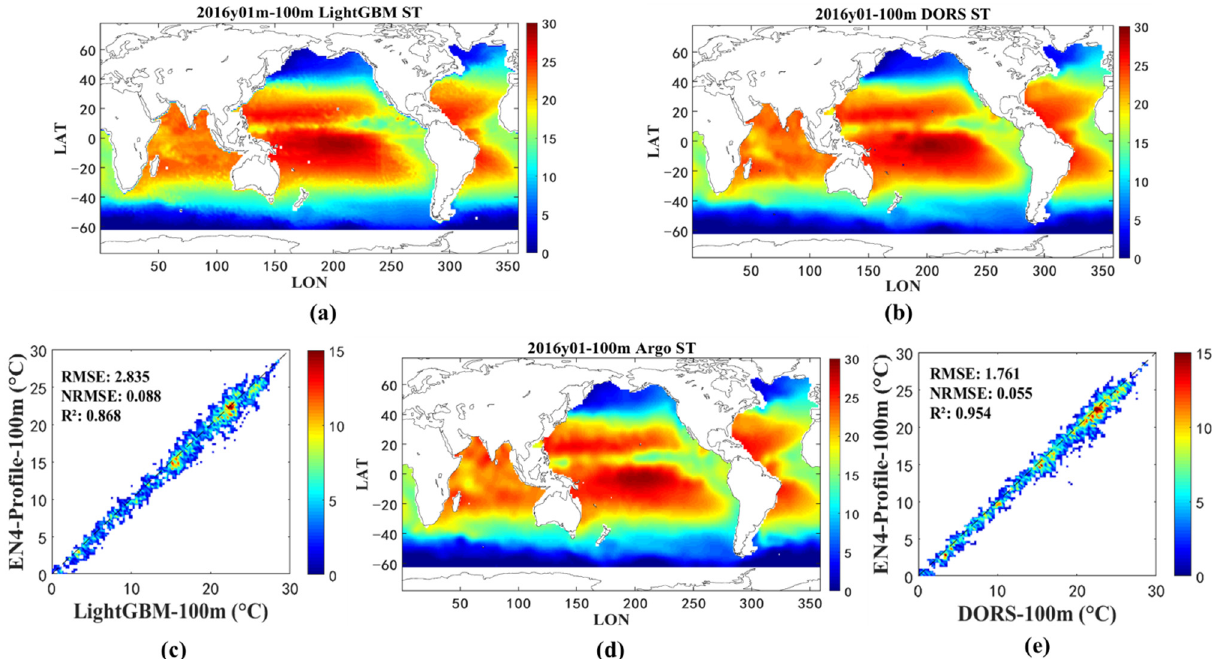
Figure 5. The spatial distributions of DORS, LightGBM, and Argo at 100 m for January 2016, and intensity scatter plots: ( a ) is the LightGBM ST, ( b ) is the DORS ST, ( c ) is the intensity scatter plots between the LightGBM ST and the EN4-Profile ST, ( d ) is the Argo ST, and ( e ) is the intensity scatter plots between the DORS ST and the EN4-Profile ST.